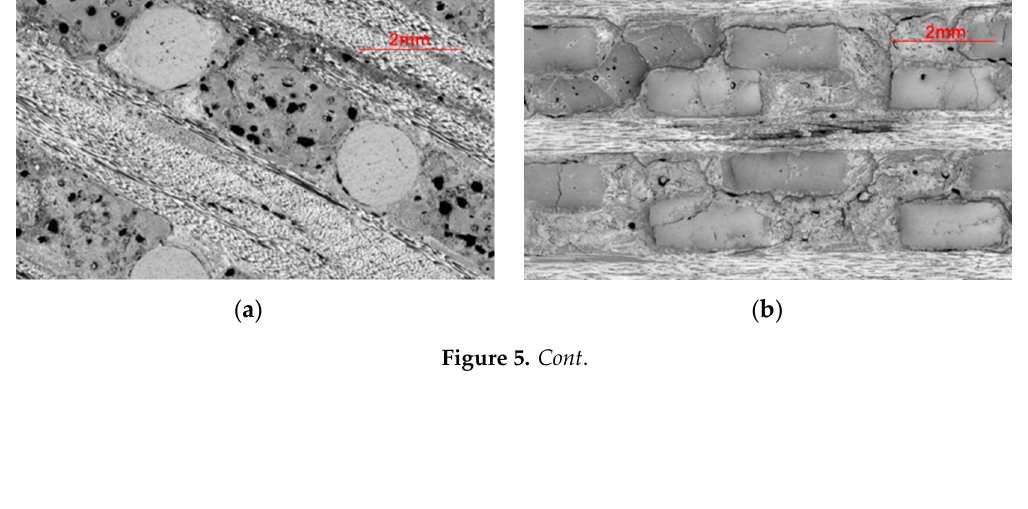
Table 2. Axially braided C/C composite material braided structure parameters (The data obtained from the observation of 100